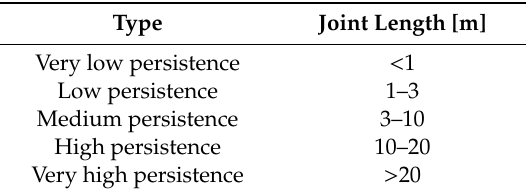
Table 4. Classification of joint persistence [76].